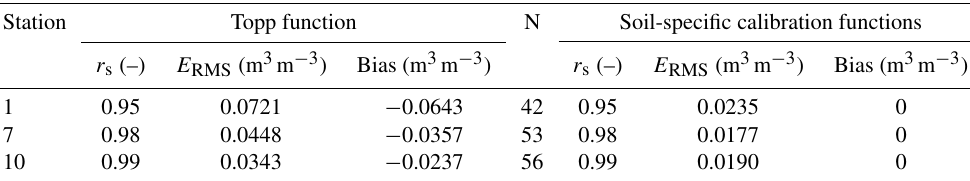
Table 5. Accuracy metrics between the GVSMs and 5TM readings converted to volumetric soil moisture content with the Topp function and the soil-specific calibration functions. Station Topp